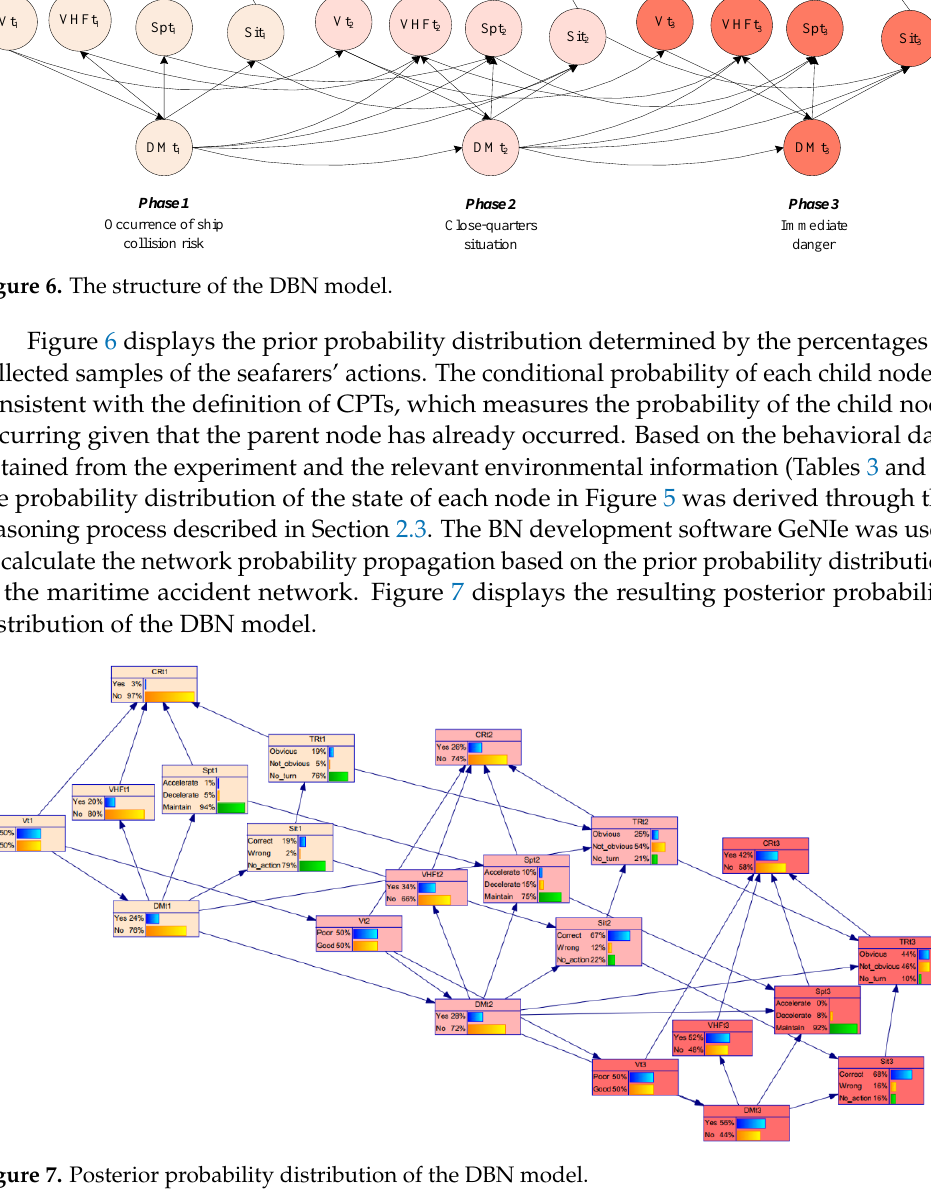
Table 6. Model validity analysis of the ship status node in the three phases.